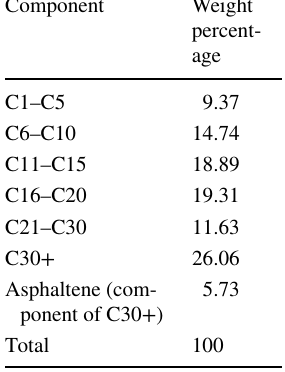
and asphaltene concentration